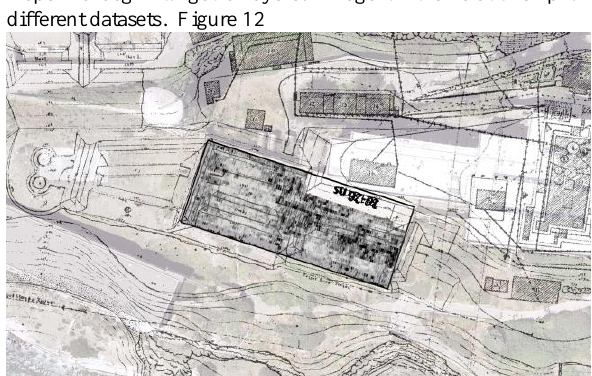
Figure 12. Combined GPR Historical Data and